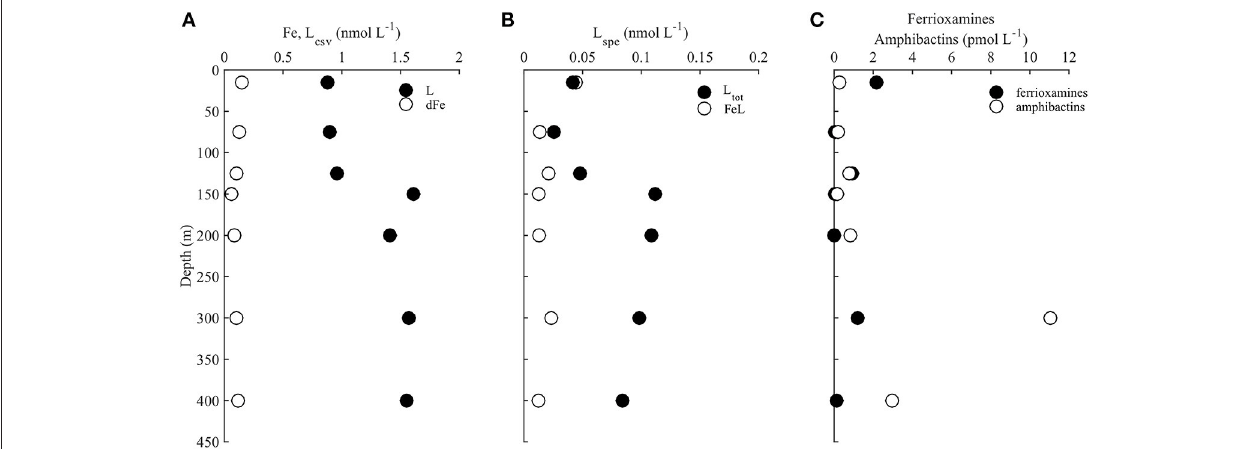
FIGURE 4 | (A) Dissolved iron (Fe, open circles) and total ligands determined using electrochemical methods (L csv , black circles), (B) iron-bound ligands (FeL, open circles) and total ligands (L tot , black circles) determined by solid phase extraction, (C) and total concentrations (iron bound and excess) of ferrioxamines (ferrioxamine G + E, black circles) and amphibactins (amphibactins T + S + D + E + H + I + F, open circles) throughout the water column at station ALOHA.